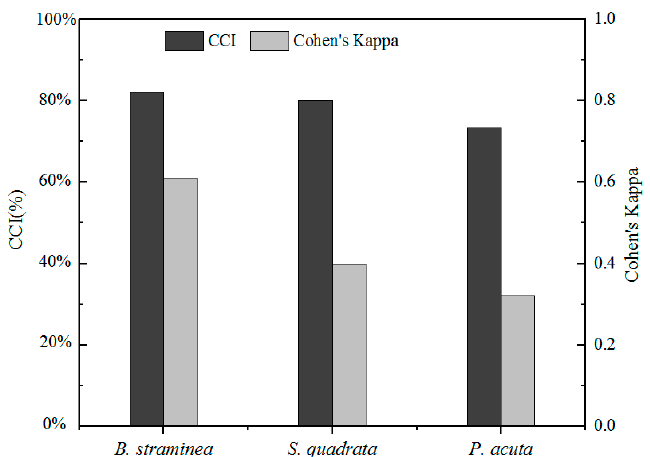
Figure 6. Overview of the average predictive performance of each classification tree model and the variation in the model based on CCI and Cohen’s kappa.